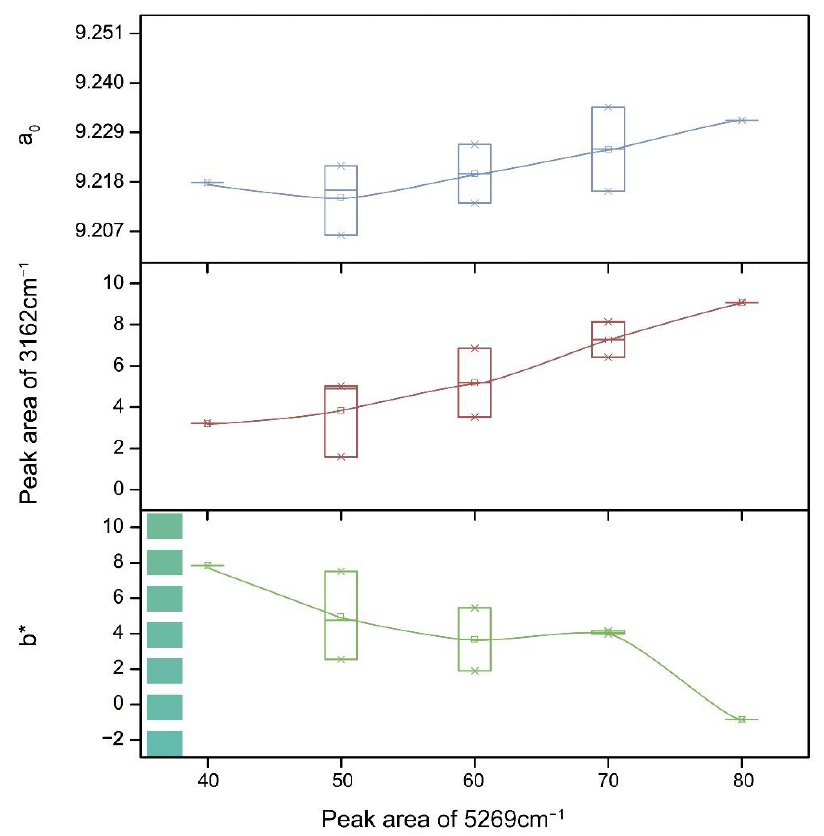
Figure 9. The IR peak area at 5269 cm − 1 was negatively correlated with the color parameter b*, and positively correlated with the Na–H absorption peak at 3162 cm − 1 , and positively correlated with cell parameter a 0 .